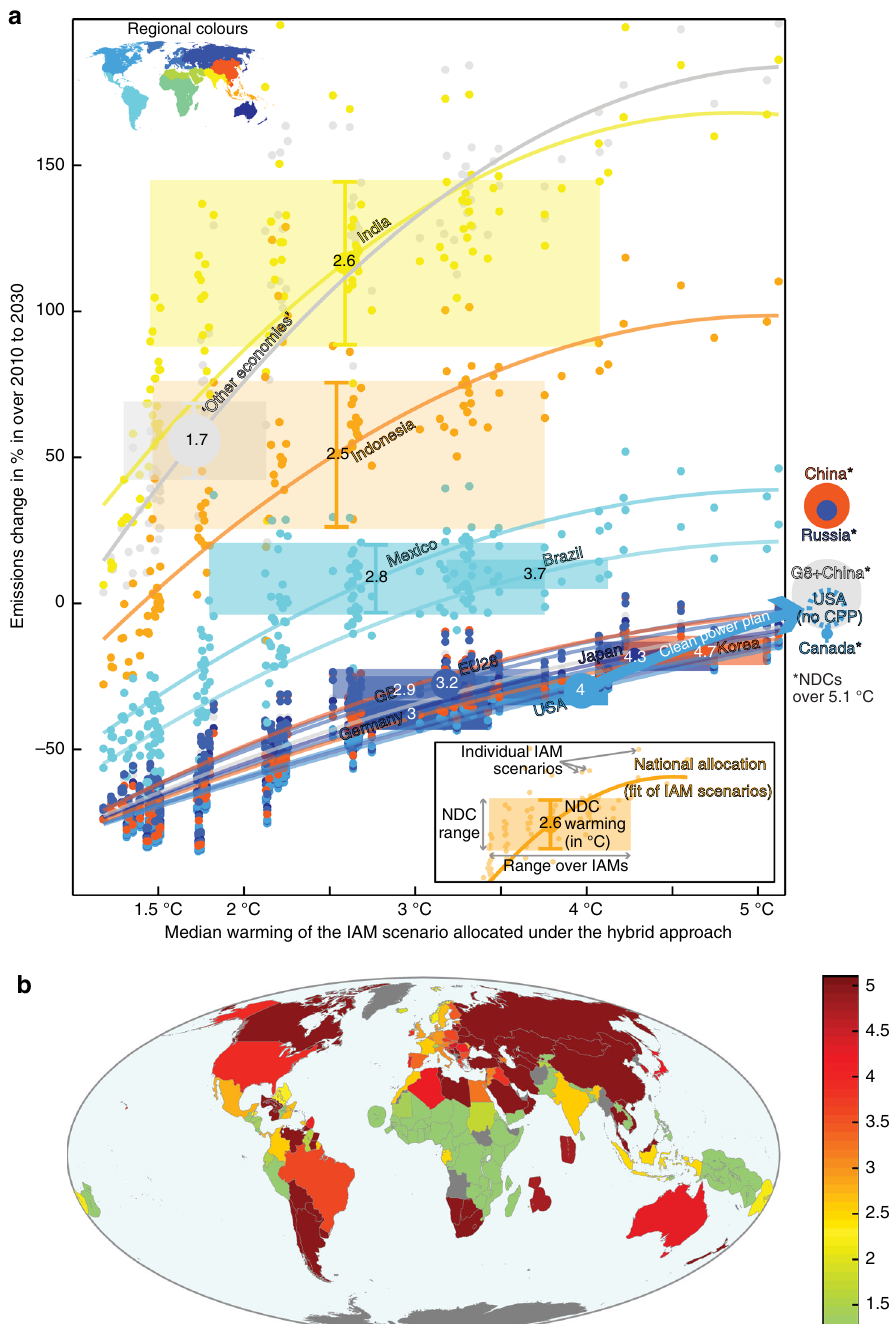
Fig. 4 Global warming responses under the CBDR-RC hybrid approach following NDCs' ambitions. a For the top fi fteen 2010-emitters, 2030-emissions as a function of median 2100-warming above pre-industrial levels under the CBDR-RC hybrid approach (coloured lines). The CBDR-RC hybrid setup combines three equity concepts: equality, responsibility and capability. Discs indicate the average NDC assessment and their sizes are proportional to 2010- emissions. Vertical ranges (coloured rectangles) indicate NDCs' evaluation ranges 44 . The horizontal uncertainty ranges (coloured rectangles) over the warmings of the IAM scenarios (coloured dots) that lie within the vertical NDC assessment range. Colours indicate countries ’ world regions (see map inset). b Global warming assessment (50% likelihood, compared with pre-industrial levels) of average NDC ambitions for 169 countries as calculated in panel a (maps with high and low NDC quanti fi cations in Supplementary Figs. 9 and 10). The assessment ranges from 1.2 °C to 5.1 °C, NDCs outside this range are not differentiated. Small island developing states are represented by their maritime